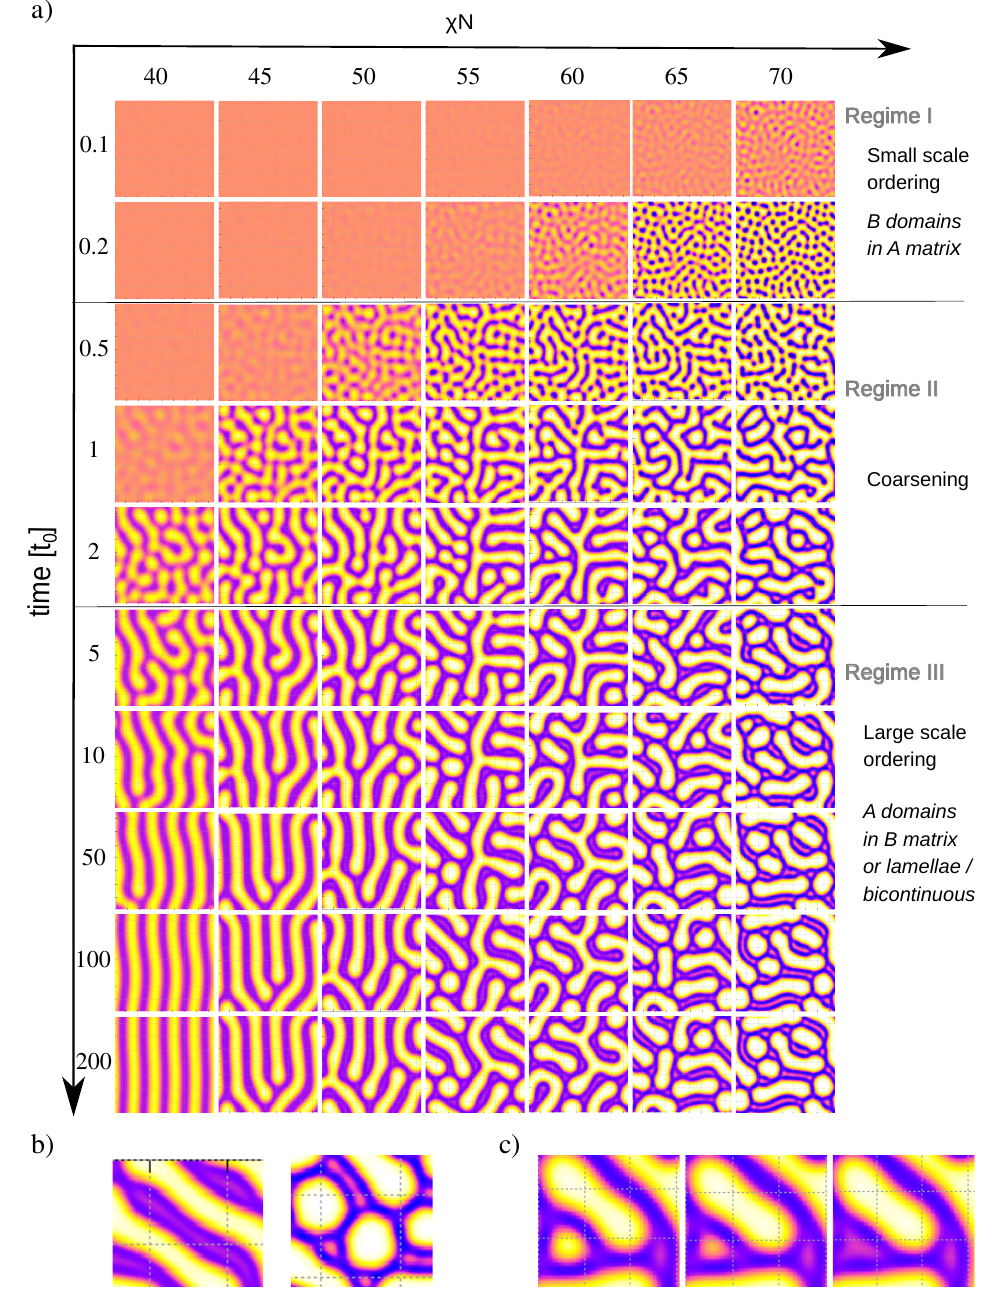
Figure 3. ( a ) Examples of ordering kinetics in A 5 m B m A m B m A m B m diblock copolymer melts for different χ N and identical disordered initial configuration. The color map is the same as in Figure 2. ( b ) Details of final structures ( t = 200 t 0 ) at χ N = 55 ( left ) and χ N = 70 ( right ) showing substructures in the B-domains. ( c ) Detail of a configuration where a substructure emerged by dissolution of an A domain. Parameters are χ N = 60 and t / t 0 =